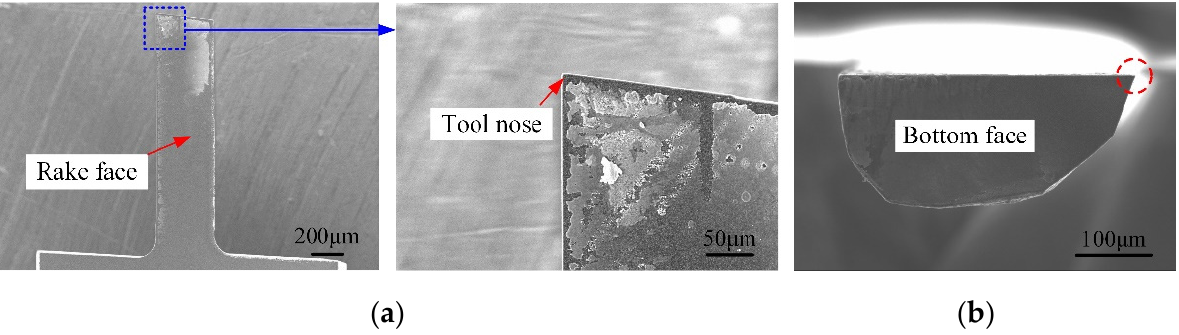
Figure 3. Self-fabricated PCD micromilling cutter. ( a ) Rake face; ( b ) Bottom face.